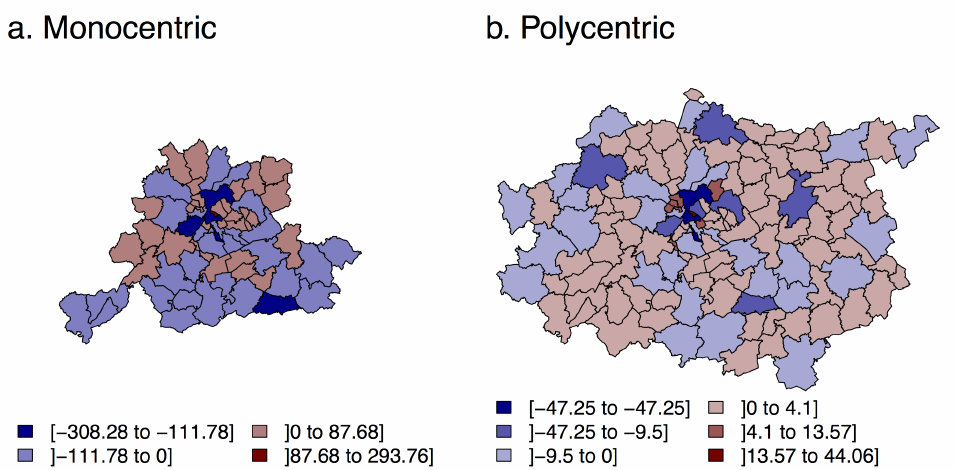
Figure 5: Differences in the number of new jobs (Municipalities – Statistical wards; discretization: